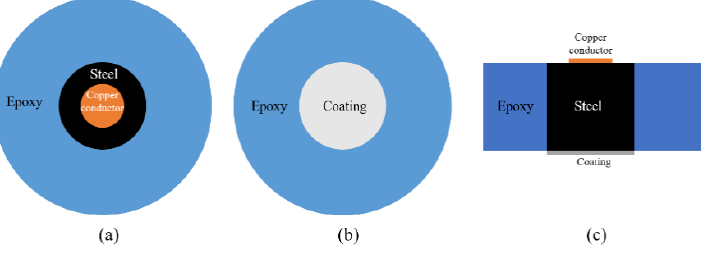
Figure 2. A schematic map of the prepared sample: ( a ) top view; ( b ) bottom view; ( c ) side view.